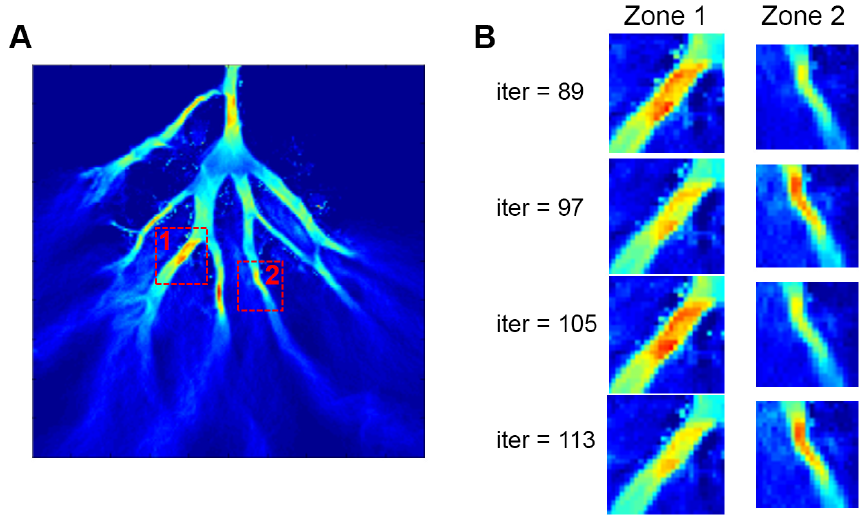
Figure 13. The dynamic balance between water surface gradient and flux distribution. (a) The dashed squares show focus areas enlarged on the right. (b) Oscillations of flow velocity between iterations in the focus areas.